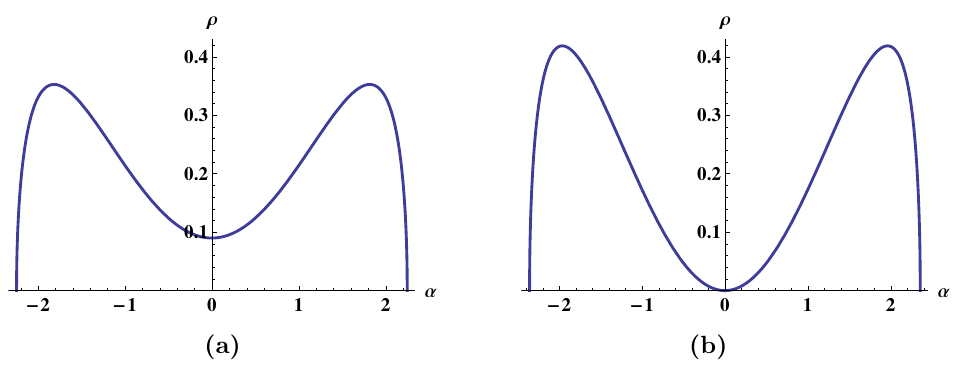
Figure 8 . Eigenvalue density. (a) (cid:28) = 2 ; (cid:21) = (cid:0) 1, corresponding to region VI. (b) (cid:28) = 2, (cid:21) = (cid:21) cr ( (cid:28) = 2), corresponding to the critical line. For higher (cid:21) , the eigenvalues split in a two- cut distribution.